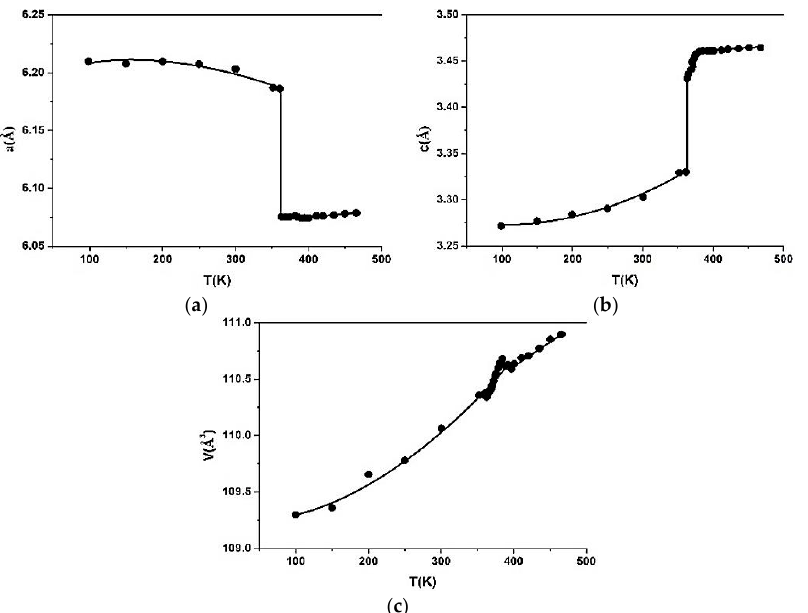
Figure 3. Thermal variation of the cell parameters for MnFeP 0.5 Si 0.5 : ( a ) a-cell parameter; ( b ) c-cell parameter; ( c ) cell volume.